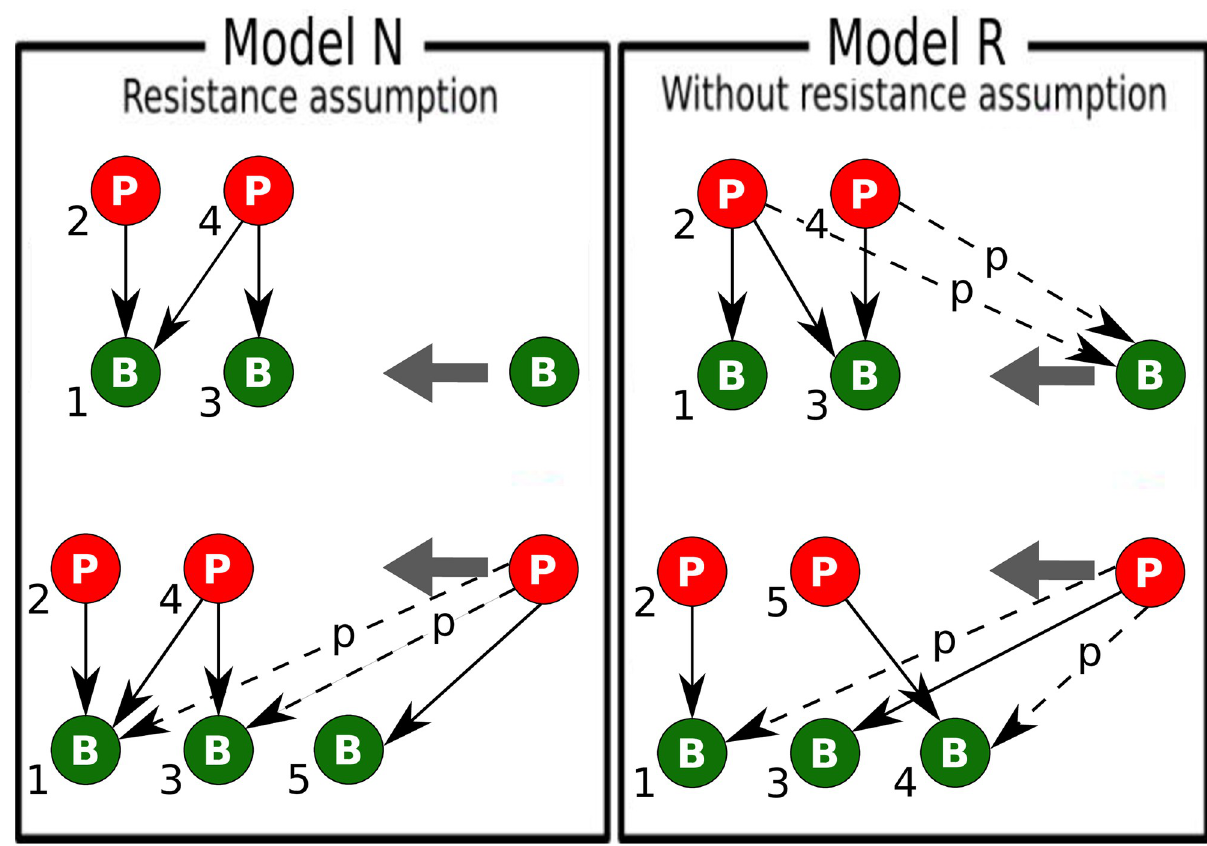
Fig 1. Schematic representation of Models N and R. The green (red) circles correspond to bacteria (phage) strains, hierarchically ordered from oldest to newest in the system (numbers). Notice that in model R, the new phage may attack a bacteria that is not the latest added. It just attacks whoever of the bacteria are not attacked by other phages (there can only be one of these). In model N the last added bacteria will automatically be the phage free one.